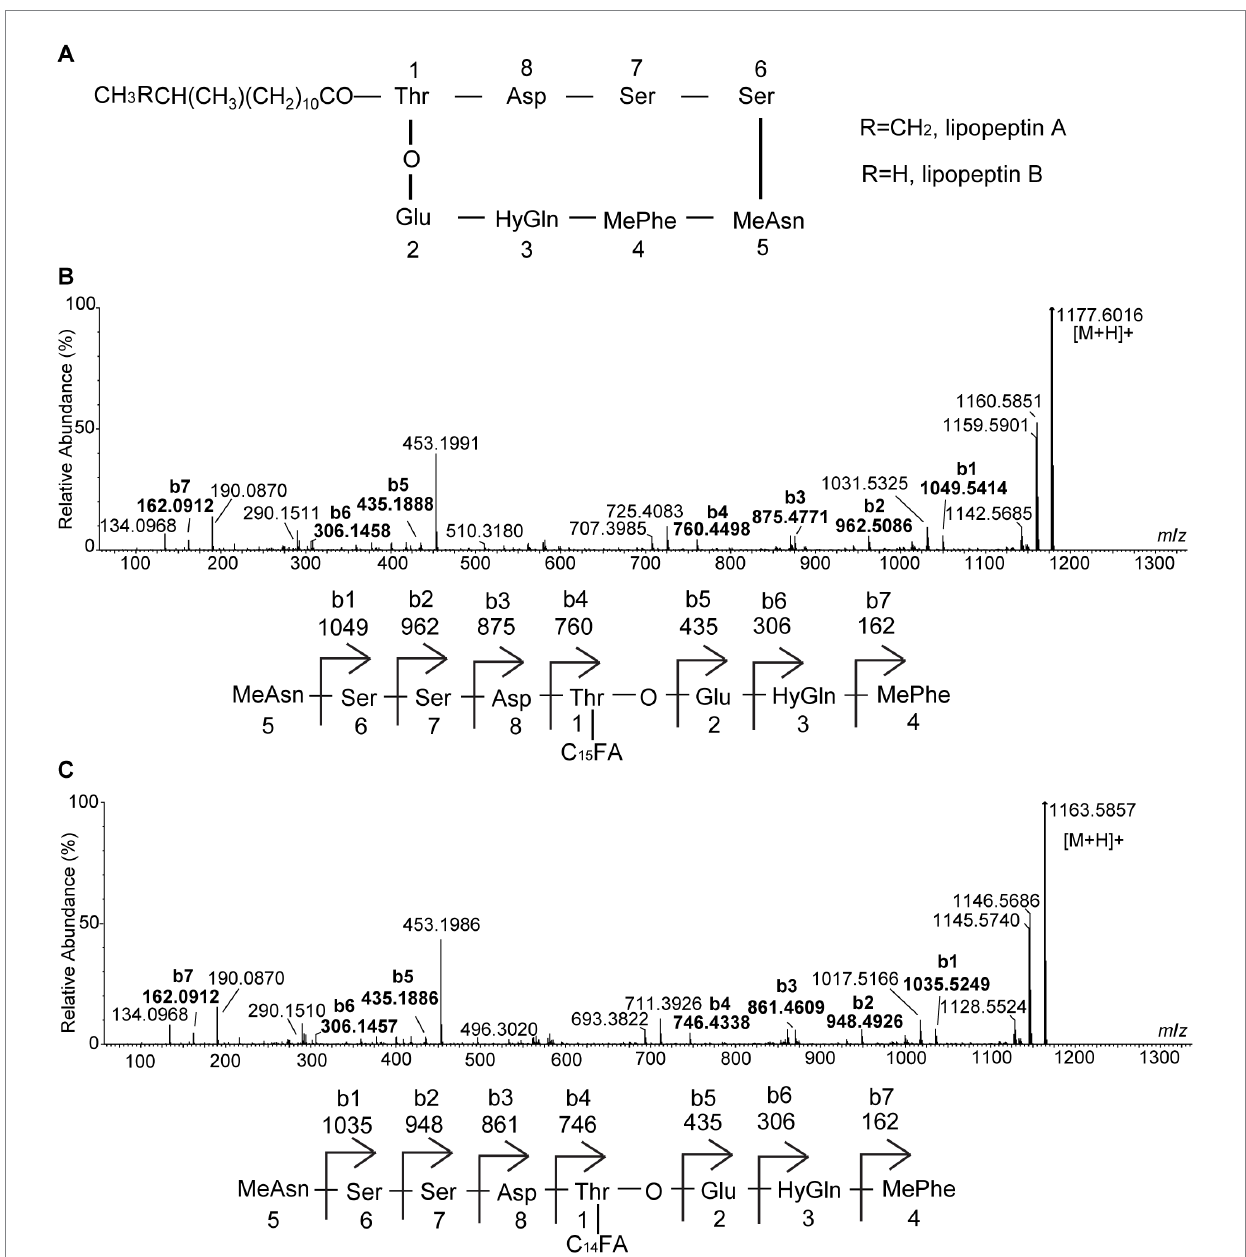
FIGURE 2 Electrospray ionization (ESI)-MS/MS (collision-induced association) spectra of the two antifungal compounds produced by strain XY006. (A) Chemical structures of lipopeptin A and lipopeptin B. (B) MS/MS spectrum of [M + H] + ion at m / z 1177.6016 eluted at 2.74 min in Figure 1A. (C) MS/MS spectrum of [M + H] + ion at m / z 1163.5857 eluted at 2.41 min in Figure 1B. The peak labels in the spectrum are observed values while predicted b series fragmentation ions are displayed at the bottom of each